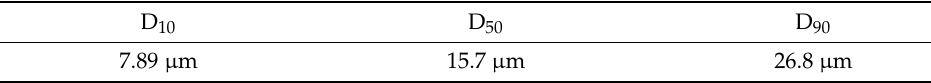
Table 2. Particle size distribution of Ti6Al4V powder.